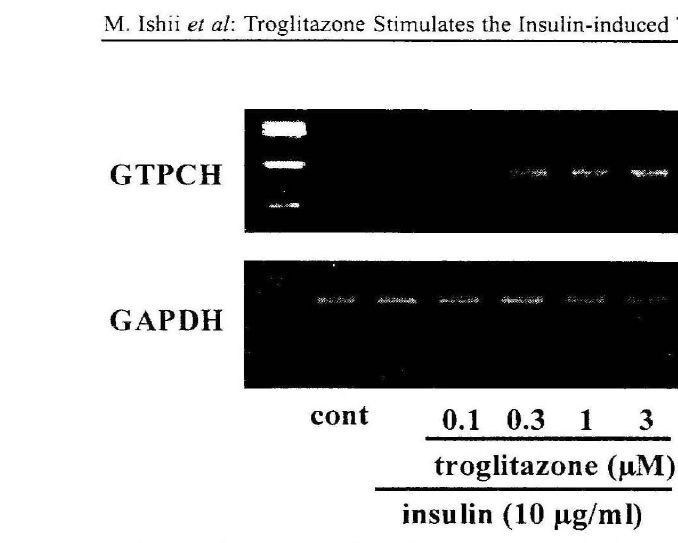
Figure 2. Effect of troglitazone on induction of GTPCH mRNA in endothelial cells treated with insulin. Cells were incubated with insulin (10 )lg/ml) in the presence or absence of troglitazone (0.1-3 ).lM) for 8 h, and followed by extraction of total RNA from the cells. Total RNA (0.1 )lg) was amplified by RT PCR using primers for GTPCH or GAPDH. DNA size markers in the left-most lane correspond to (bp): 525, 500, 400 and 300.